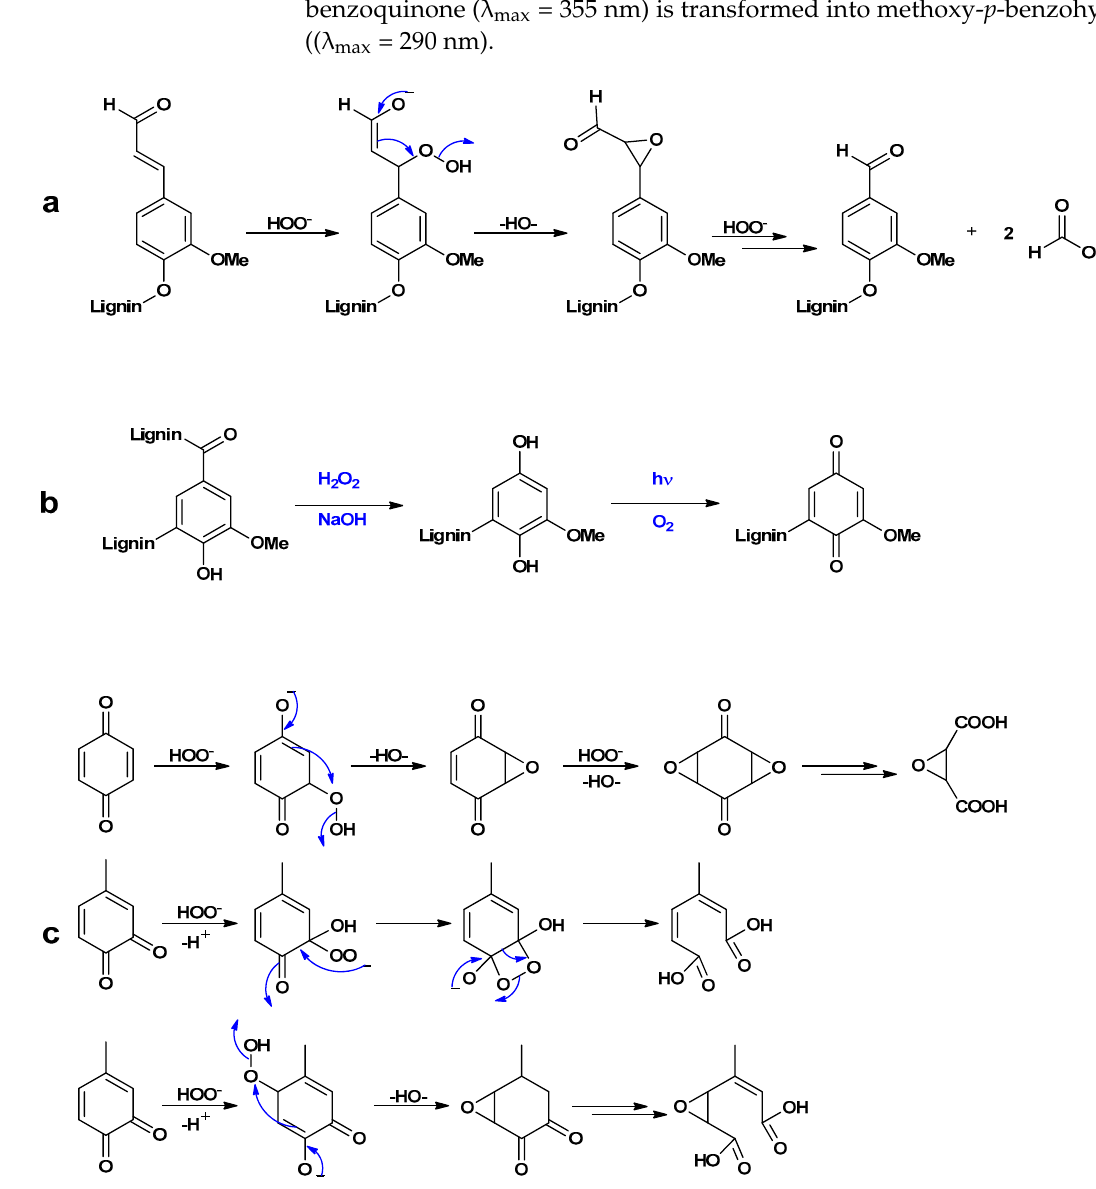
Figure 4. Reactions of perhydroxyl anions on coniferaldehyde units ( a ), vanillin-type units ( b ), and quinone-type units ( c ) [27,37,38,40].